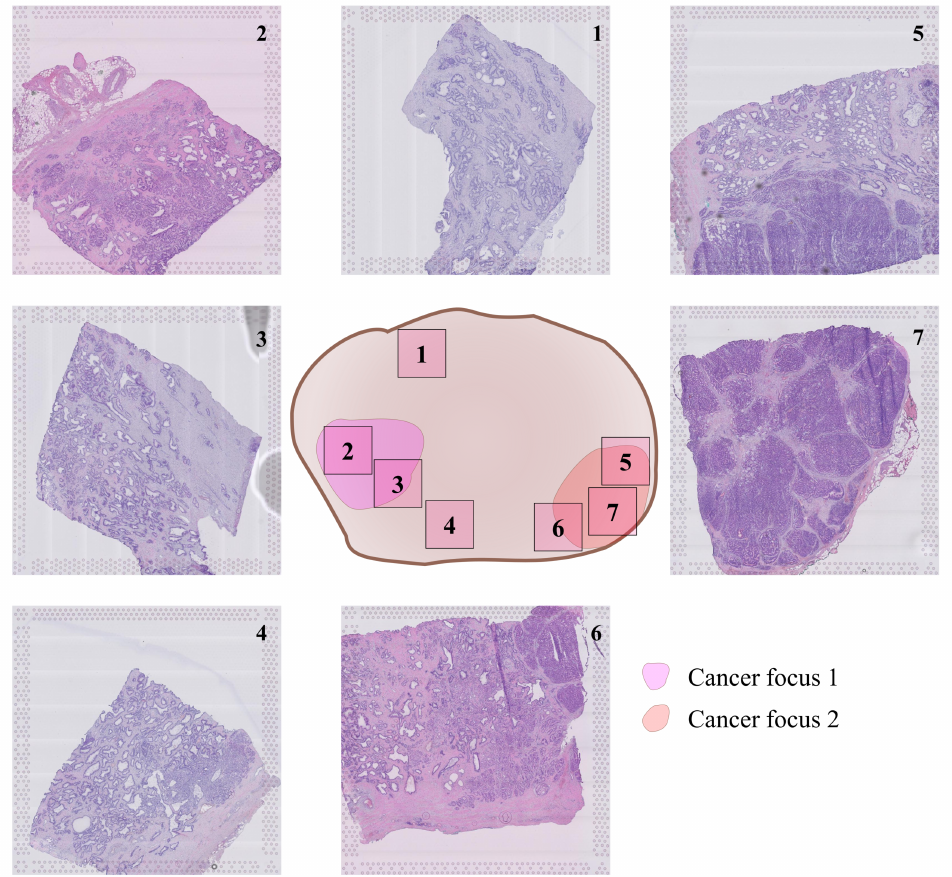
Figure 1. Location of tissue sections inside prostatectomy, provided by Erickson et al.